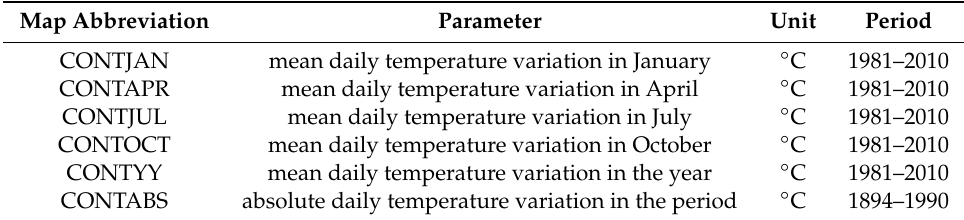
Table 2. Resulting temperature continentality maps and intermediary files.